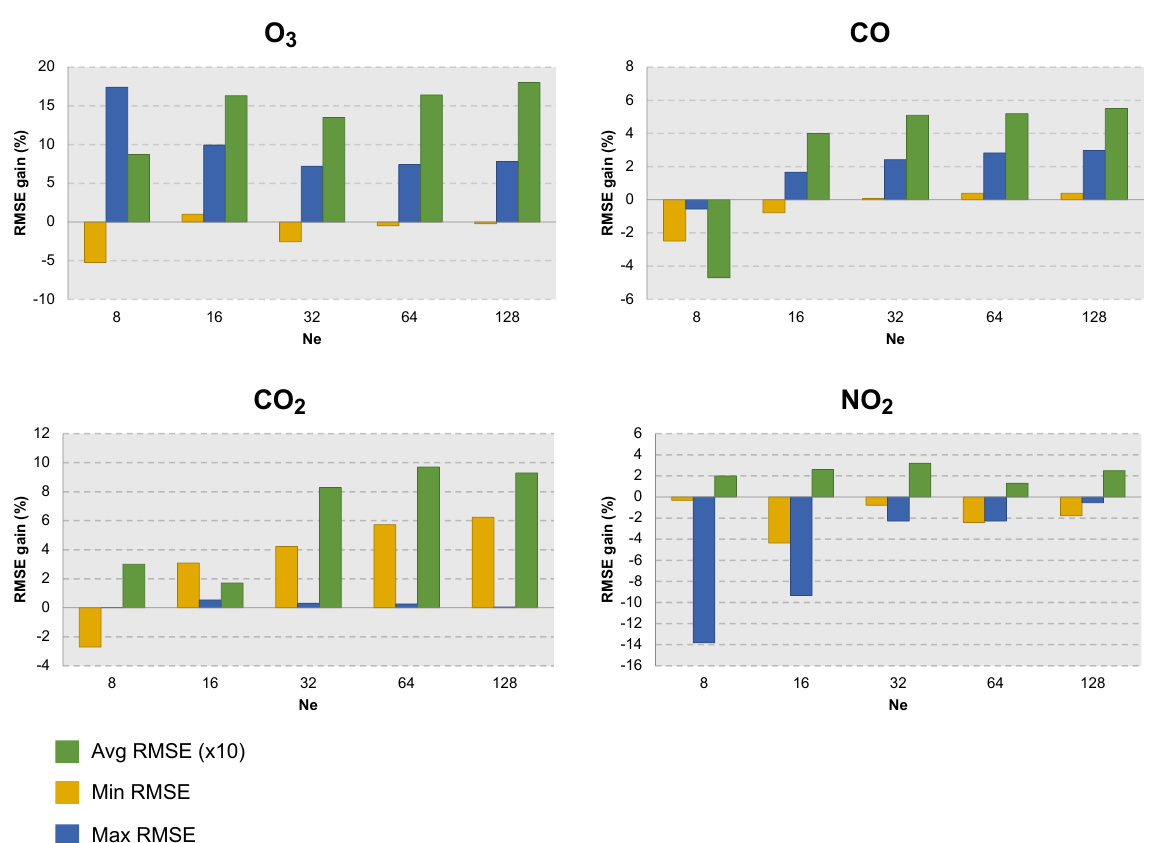
Figure 5. Impact of ensemble size (Ne) on the RMSE gain of the 4DEnVar analyses. Results are shown for the four chemical species: O 3 , CO, CO 2 and NO 2 . For each plot, values of maximum, minimum and average RMSE gain (Table 6) are shown in different color, compared to reference results obtained with 3D-Var. Positive values mean better RMSE gain with 4DEnVar than with the reference 3D-Var. Average RMSE gain has been multiplied by 10 to better highlight the differences among the